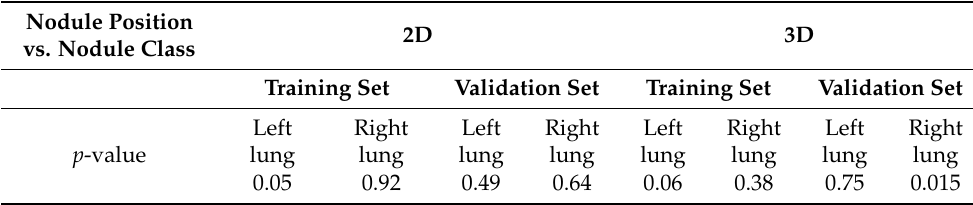
Table A4. The p -values corresponding to the χ 2 test between the diagnostic class of a nodule and its relative position in axial and sagittal planes. p -value < 0.01 was indicating the presence of a significant